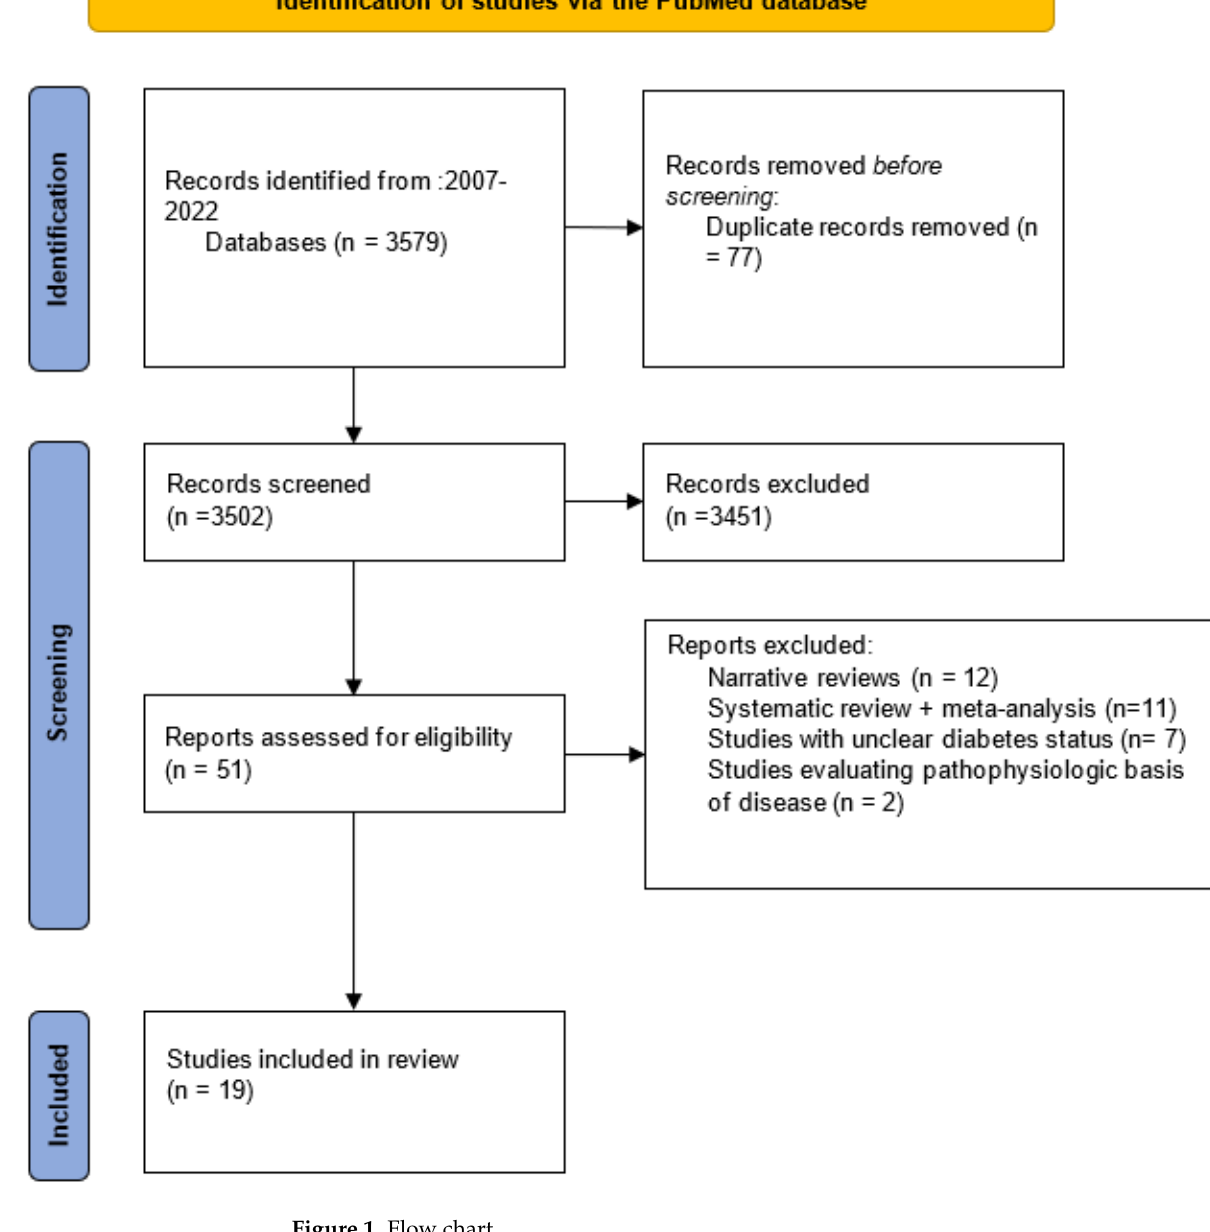
Figure 1. Flow chart.